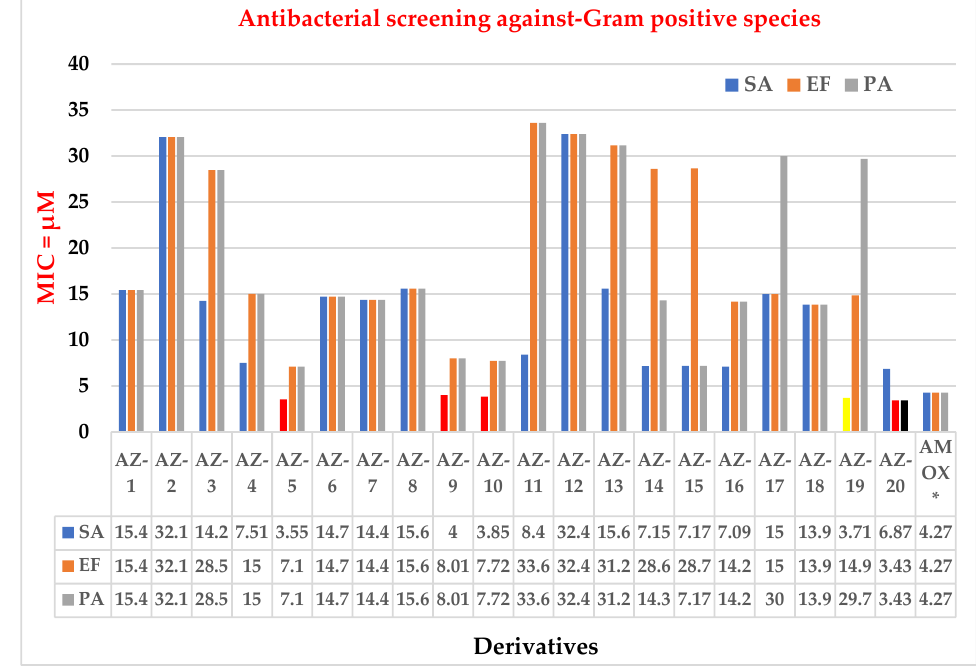
Figure 3. Antibacterial screening against Gram positive species of synthesized derivatives. *-Standard